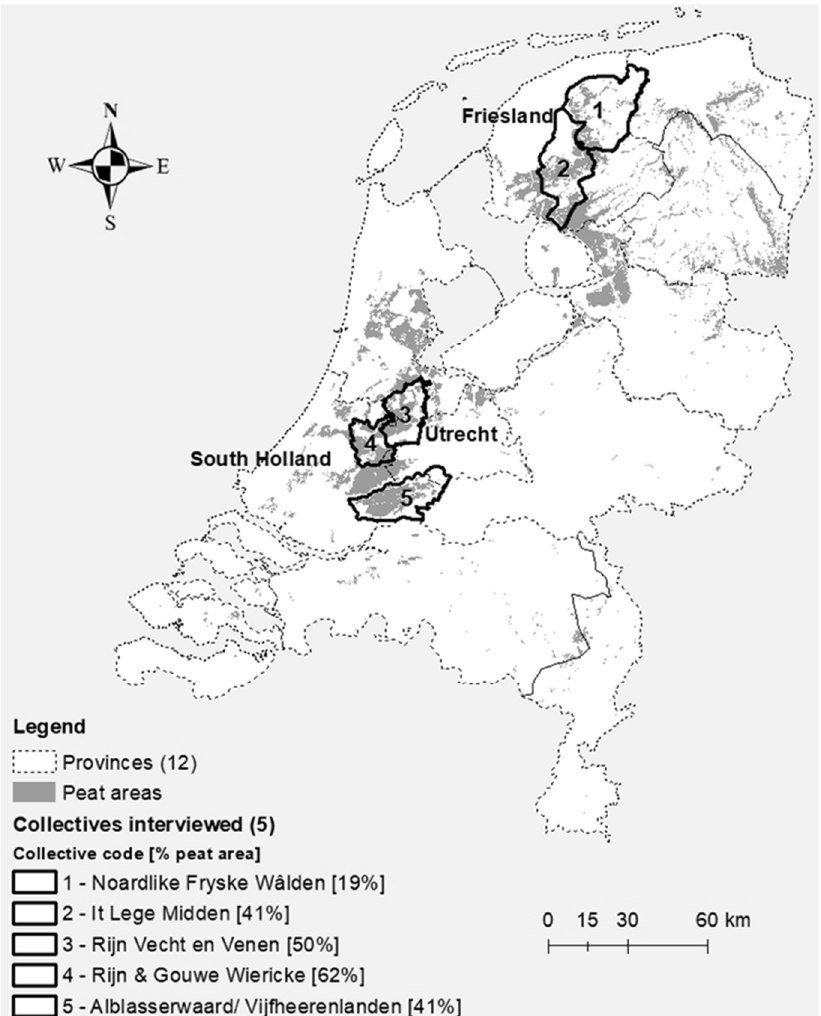
Figure 1. Map of Dutch peat areas overlain by regions of the five collectives interviewed in this study. (Map creation: author’s own, using ArcMap [ESRI]. Geospatial data sources: BoerenNatuur [collective areas], GADM [administrative boundaries]) and Wageningen University and Research [peat soil areas]).